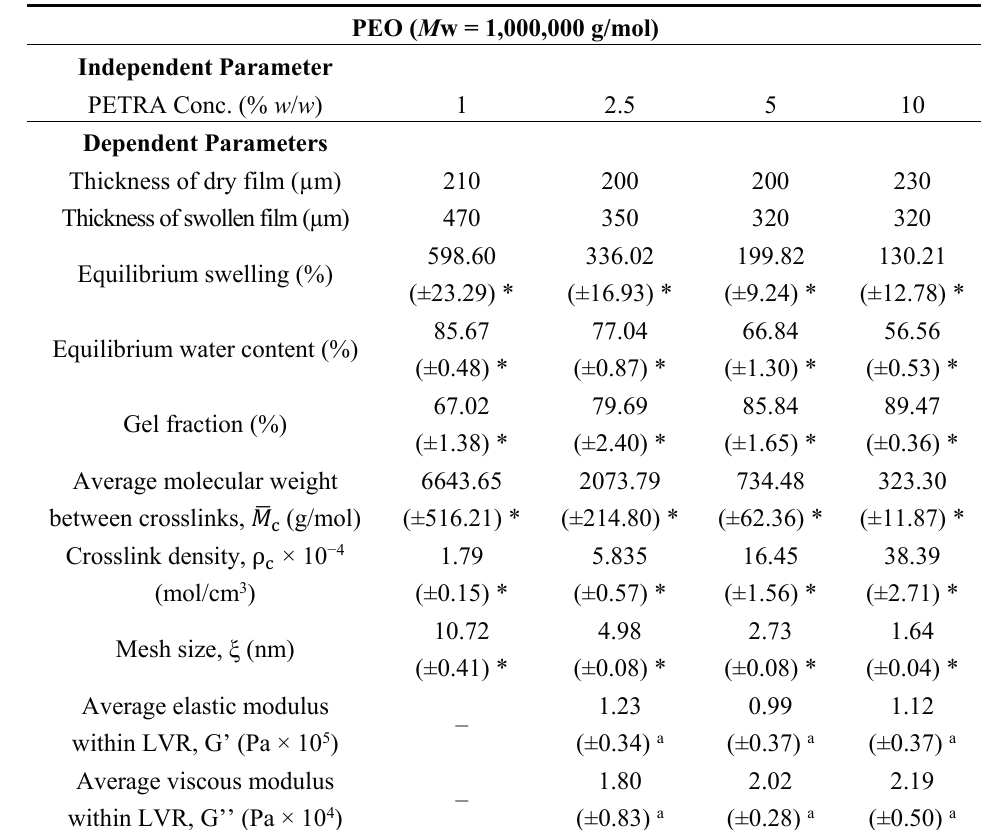
Table 1. Effect of PETRA concentration on the dependent variables involved in the swelling and rheological experiments of PEO hydrogel film samples. Values in brackets indicate the standard deviation from the reported